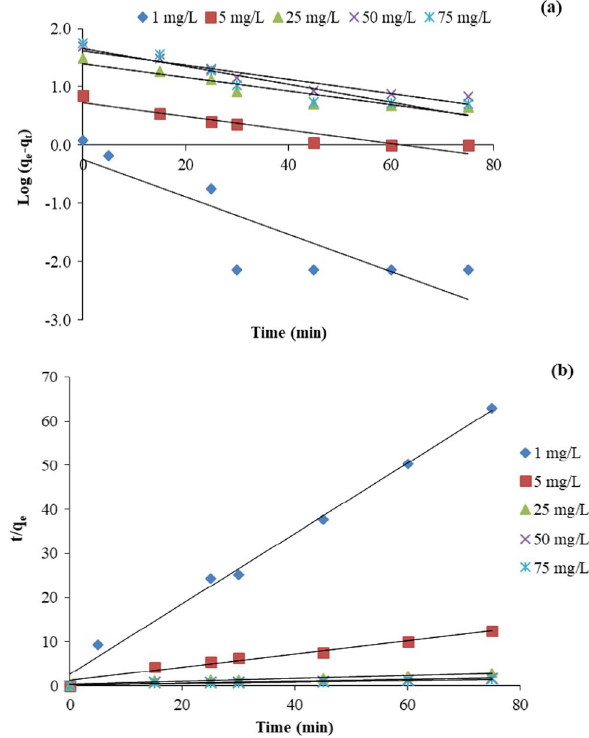
Fig. 7 Pseudo-first ( a ) and second-order ( b ) kinetic model in DZN adsorption using AC–ZnO